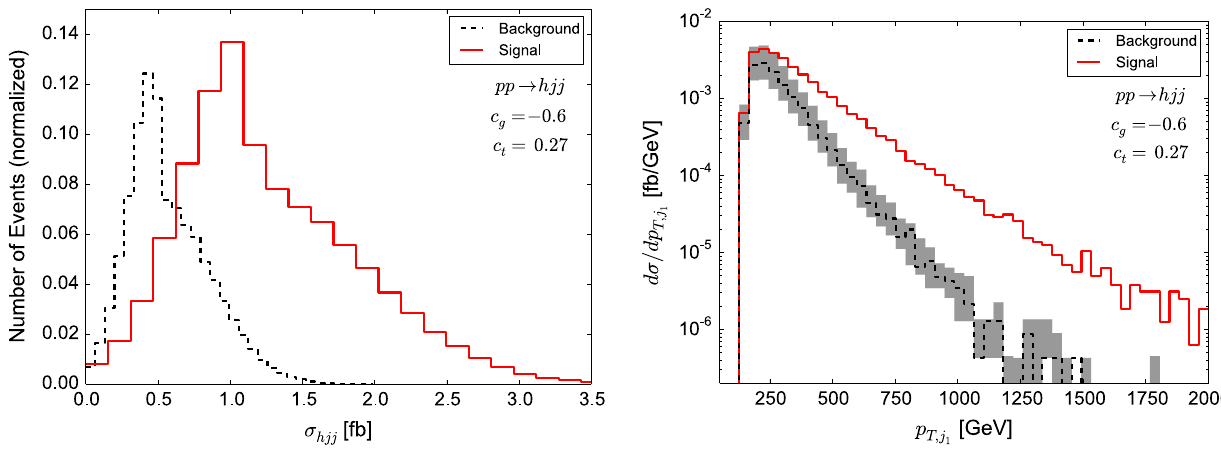
Fig. 3 Cross section observable and jet-transverse momentum distribution in h + 2 jets production for an operator choice ( c g , c t ) = ( − 0 . 6 , 27 ) . For further details see